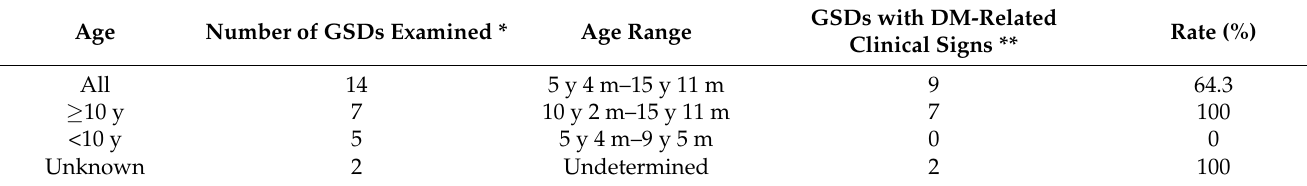
Table 3. Clinical progression rate of degenerative myelopathy (DM) in German Shepherd Dogs (GSDs) with the risk genotype ( SOD1